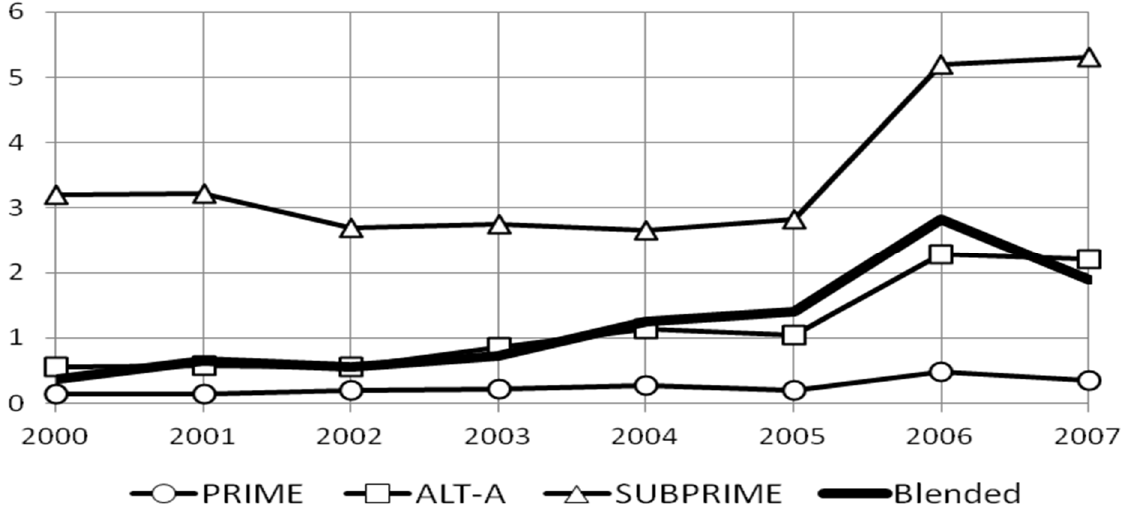
Figure 2. Projected Credit Losses and Rates Annual Loss Rate. Source: Davidson Company Inc.